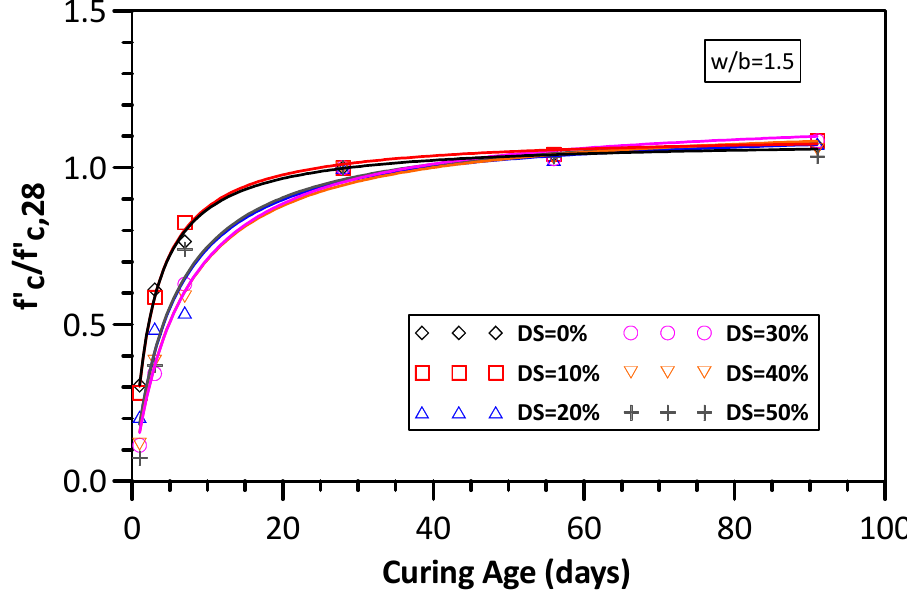
Figure 8. Hyperbolic function relationship of the compressive strength and surface resistivity with various DS contents of the CLSM.